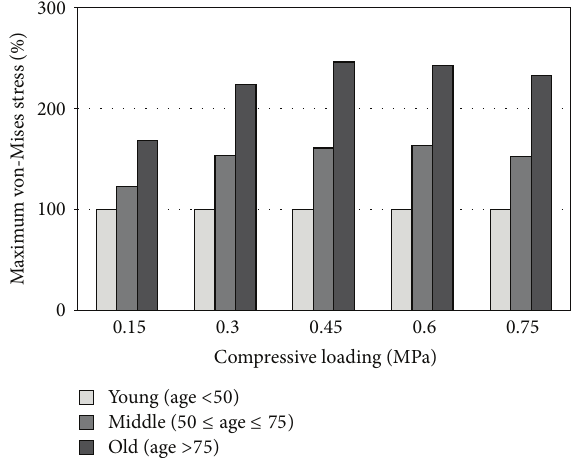
Figure 5: Ratios of the maximum stress for the middle and old groups relative to the young group under 0.15MPa, 0.3 MPa, 0.45 MPa, 0.6 MPa, and 0.75 MPa of compressive